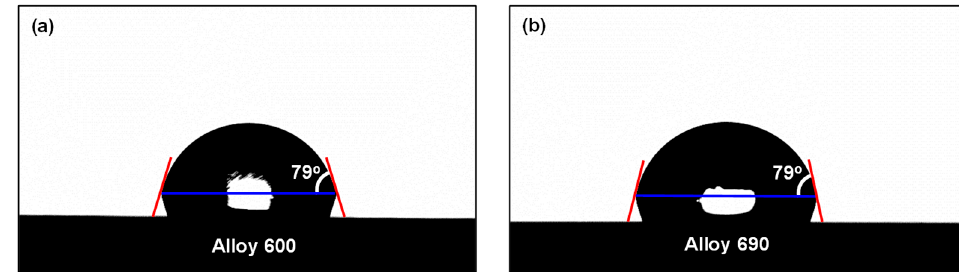
Figure 4. Static contact angles measured on SG tubes: ( a ) Alloy 600 and ( b ) Alloy 690.